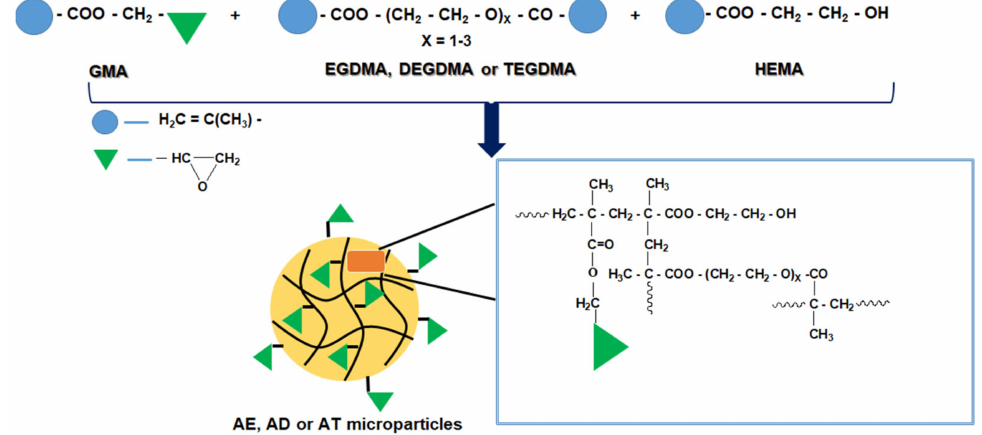
Figure 1. Schematic representation of the reaction to obtain precursor microparticles (AE, AD or AT).